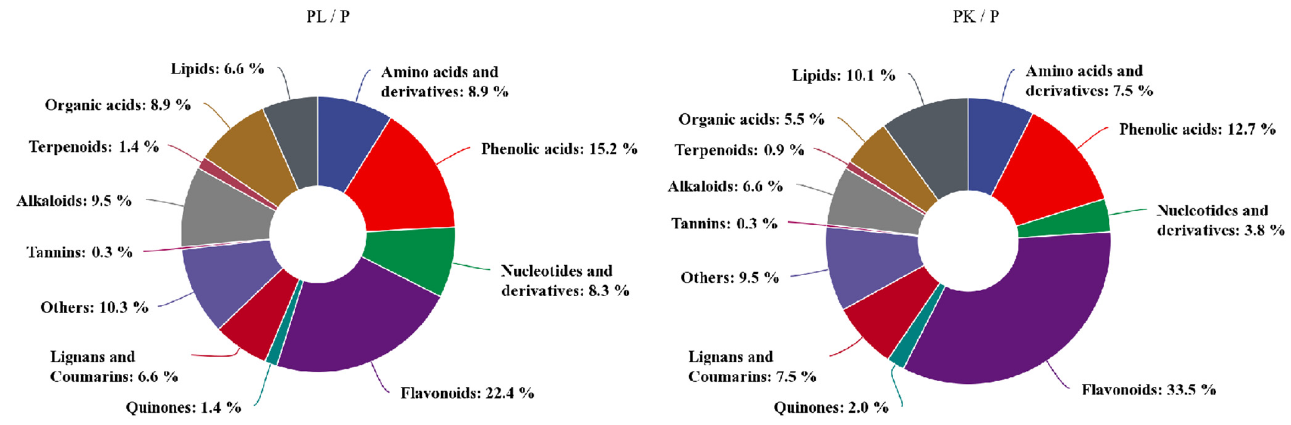
Figure 2. The categorization of DAMs in D. officinale post light- or K-treatment. PL represents light-treated D. officinale whereas PK means potassium-treated seedlings. Table 1. The changed pattern of flavonoids and JAs in light- and K-treated D. officinale .